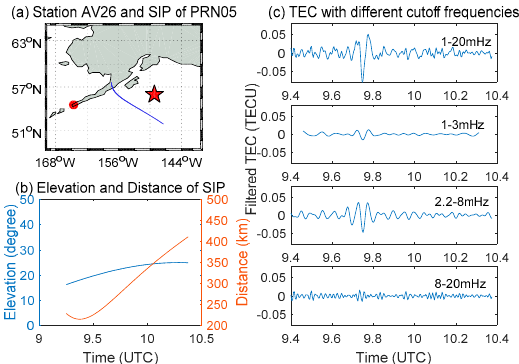
Figure 2. The filtered TEC (total electron content) observed by station AV26 and PRN 05 during the Alaska earthquake on 23 January 2018. In ( a ), the blue line is the SIPs (sub-ionospheric points) track. The star and the point show the location of the epicenter and AV26 station. ( b ) shows the elevation angle of the satellite (the blue line) and the distance between the SIPs and the epicenter (the red line). ( c ) is the TEC obtained through di ff erent cuto ff